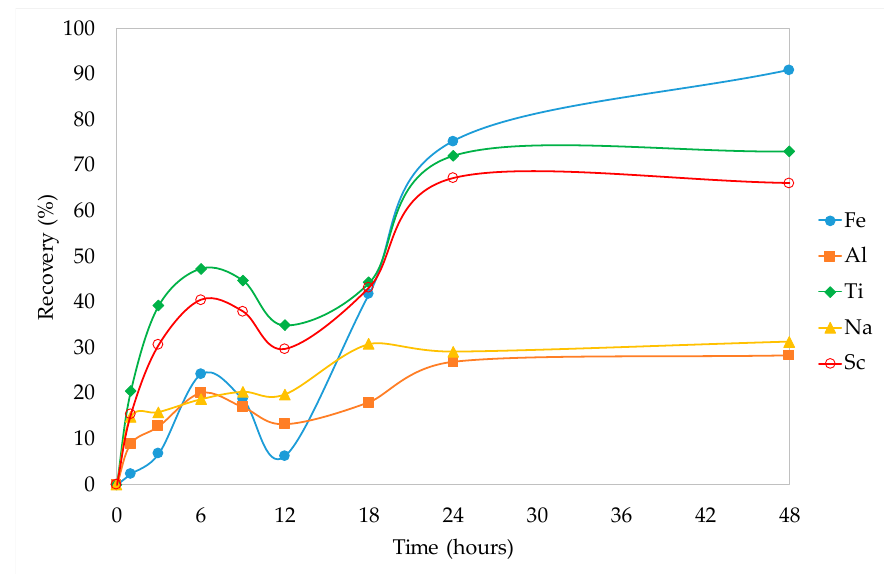
Figure 4. Kinetic curves for metals dissolution by leaching BR with [Emim][HSO 4 ] at 1, 3, 6, 12, 18, 24 and 48 h, 200 rpm, 150 °C and 5% w / v pulp density.